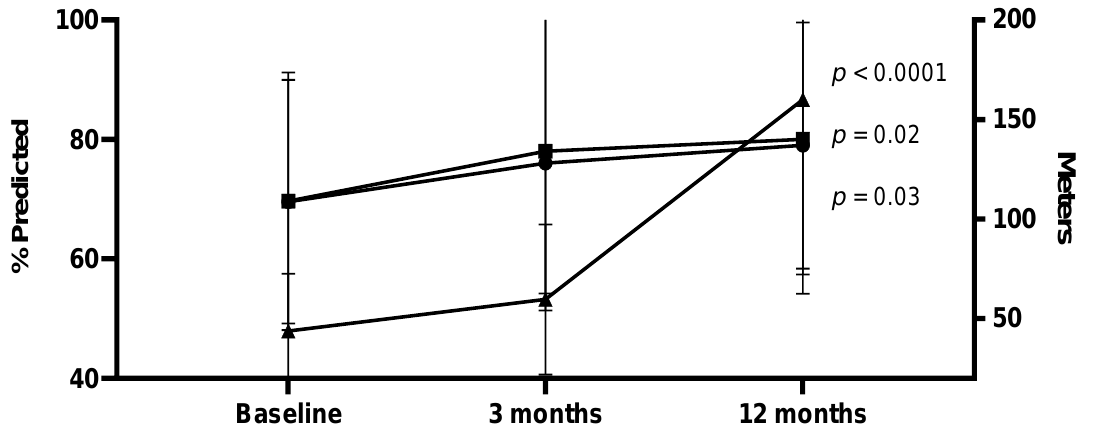
Figure 3. Spirometric values (forced expiratory volume in one second (FEV1) and forced vital capacity (FVC) and the six-minute walking test (6MWT) distances at different time points following ICU discharge. Data are presented as mean (SD) values.